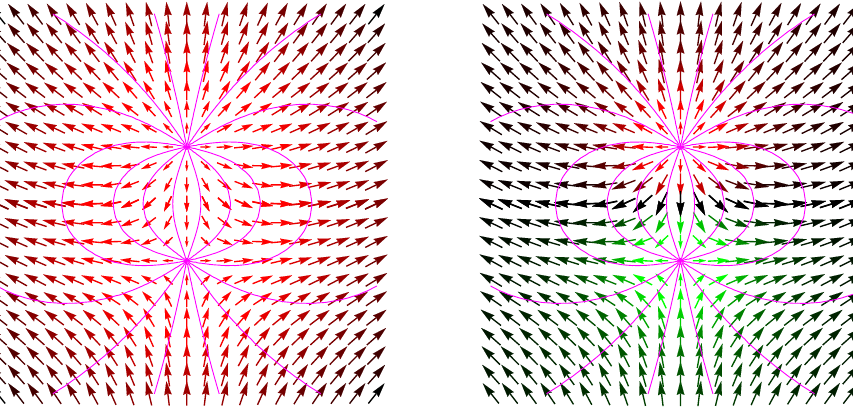
Figure 2. Schematic diagrams depicting the imaginary part ~q = ~n sin α of the Q -field (2) of two opposite unit charges by arrows. The lines represent some electric flux lines. We observe that they coincide with the lines of constant ~n -field. The configurations are rotational symmetric around the axis through the two charge centres. In the red/green arrows, we encrypt also the positive/negative values of q = cos α . For q 0 the arrows are getting 0 0 → darker or black. The left configuration belongs to the topological quantum numbers Q = S = 0 and the right one to Q = S = 1, where S is the total spin quantum number of this dipole configuration.